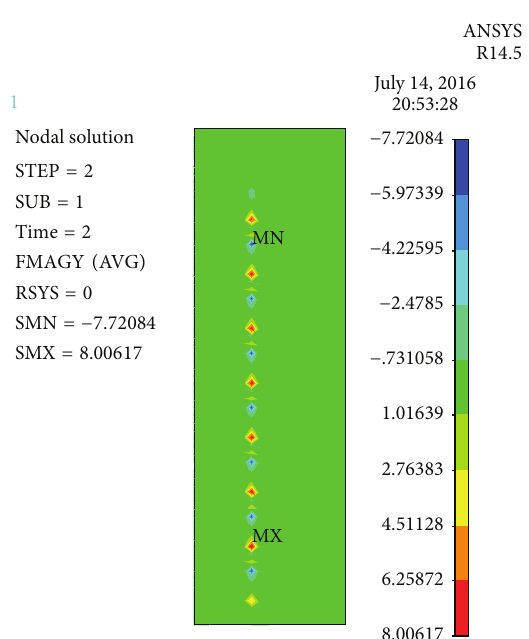
Figure 9: Magnet force distribution of the linear power generator.